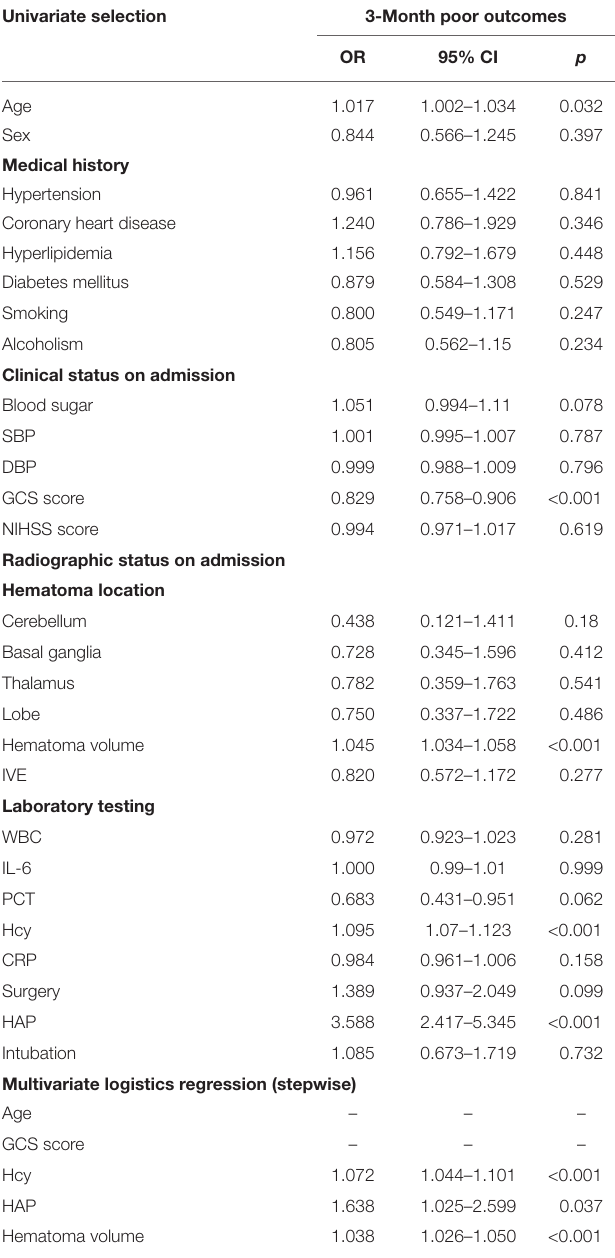
TABLE 3 | Univariate and multivariate analyses of the potential predictors for poor outcomes.